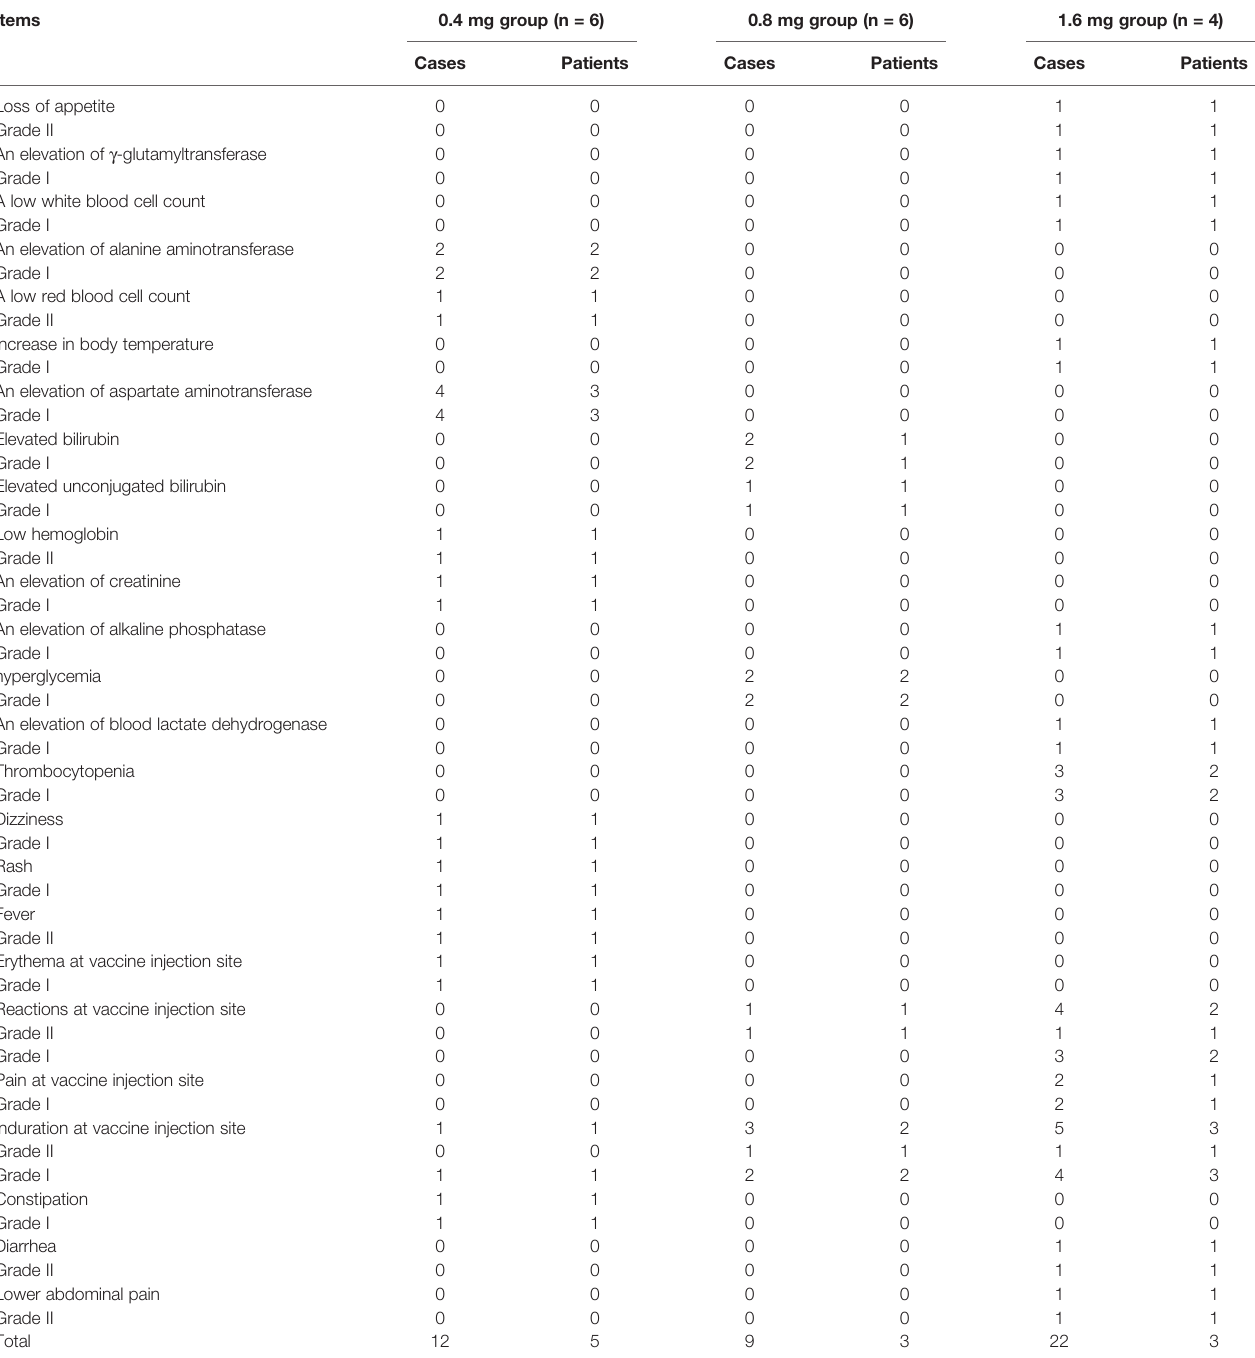
TABLE 2 | EGF-CRM197 treatment -related AEs.